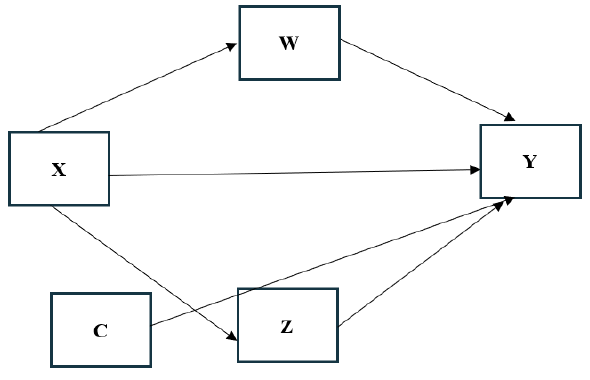
Figure 1. Moderation model.